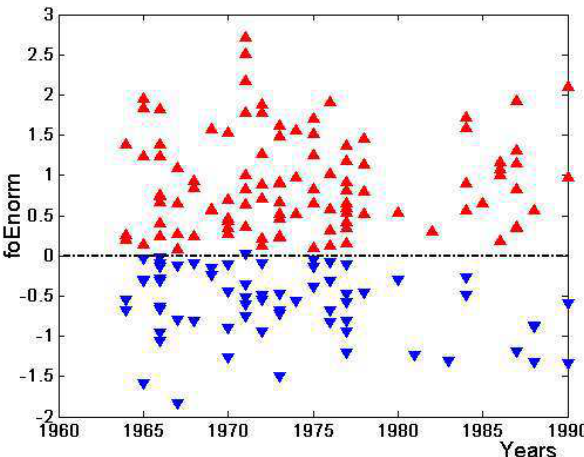
Fig. 4. Variations of foE norm on the day (-1) of all winter-